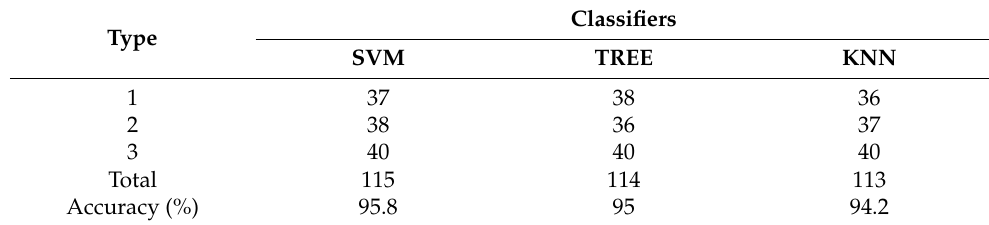
Table 3. Number of correctly identified